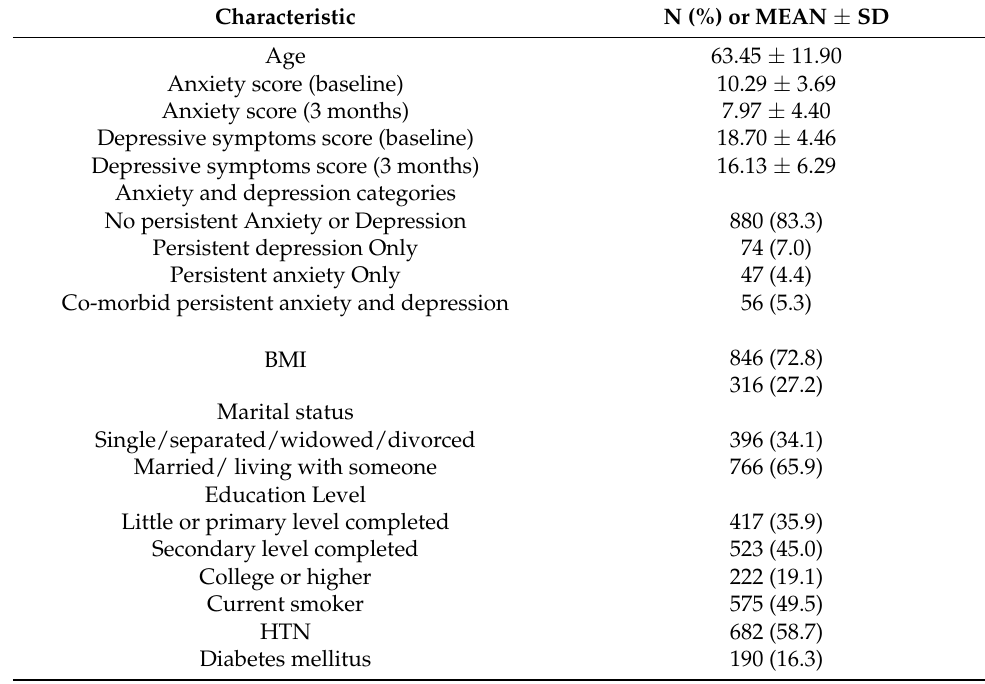
Table 1. Sample baseline characteristics (N =